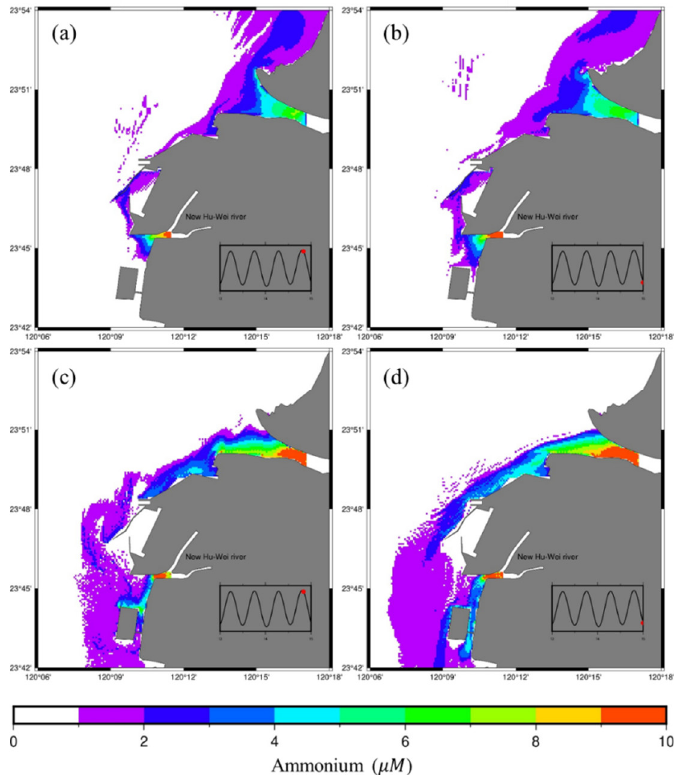
Figure 15. The color image represents the distribution of the model ammoni-um-concentration fields, while southwest winds are prevalent during the ( a ) high slack water and ( b ) low slack water, and while northeast winds are prevalent during the ( c ) high slack water and ( d ) low slack water. The inserts at the lower-right corner indicate the tidal phase.